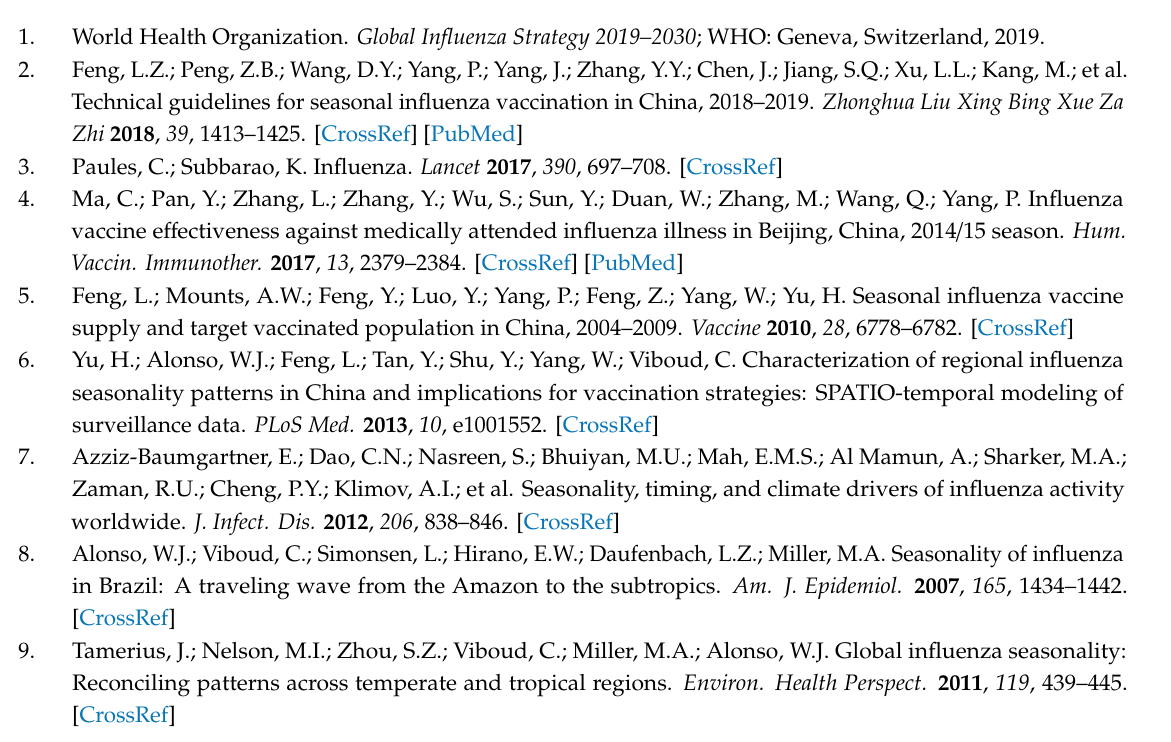
Figure S1: Location of Yichang city, Hubei Province, China. Figure S2: Temporal trends of influenza virus activity by type, Yichang, Hubei, 2013–2019. Influenza virus-positive cases by virus type (influenza viruses A and B). The shaded area represents the total number of specimens tested. The dark blue dotted line indicates the positive rate of influenza. Figure S3: Distribution of positive rates by subtypes / lineages of influenza viruses A and B in di ff erent seasons in the six-year study period. Figure S4: Heat map of influenza virus activity in Yichang, Hubei, 2013–2019. Table S1: Characteristics of seasonal influenza virus in Yichang, Hubei, 2013–2019. Table S2: Age-specific influenza positive rate, Yichang, Hubei, 2013–2019. Table S3: Detailed results of positive rates by age group and subtype / lineage, Yichang, Hubei, 2013-2019. Table S4: Age distribution of influenza-positive patients in di ff erent surveillance years, Yichang, Hubei,